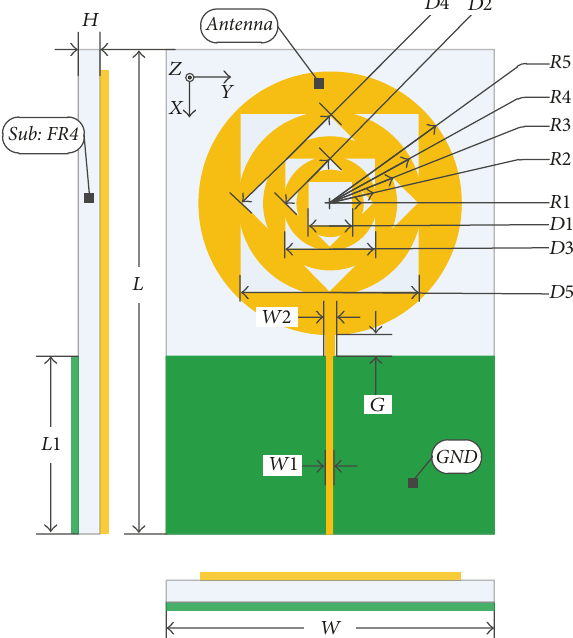
Figure 1: Layout of the proposed antenna.